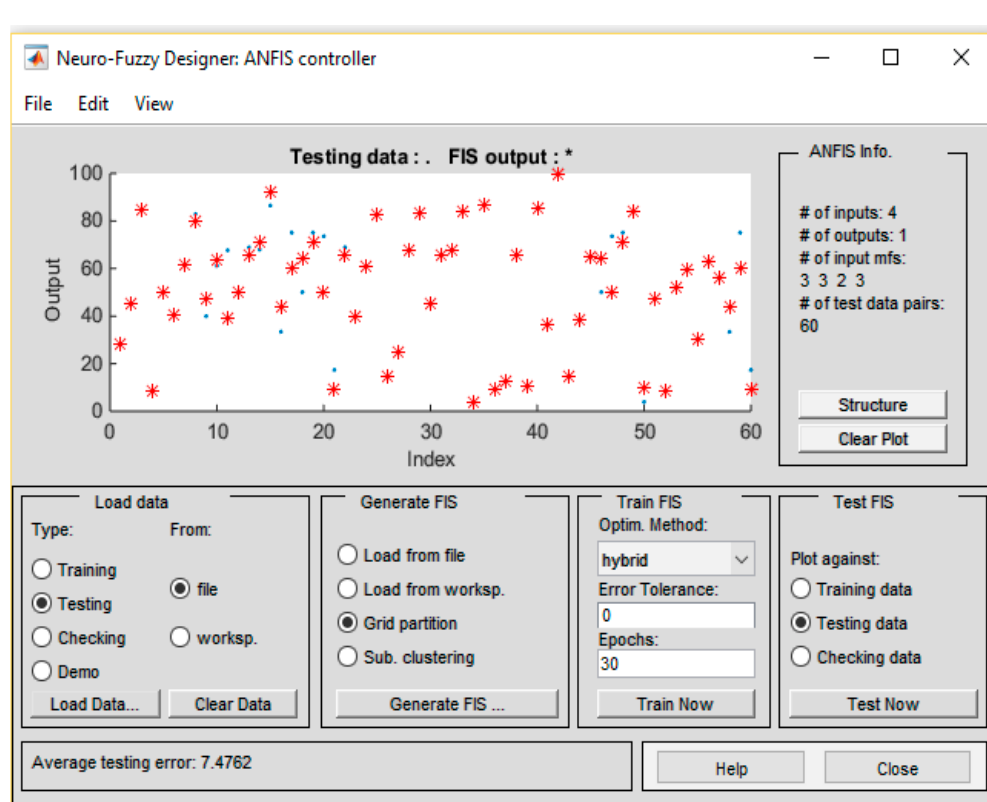
Figure 18. Average testing results.